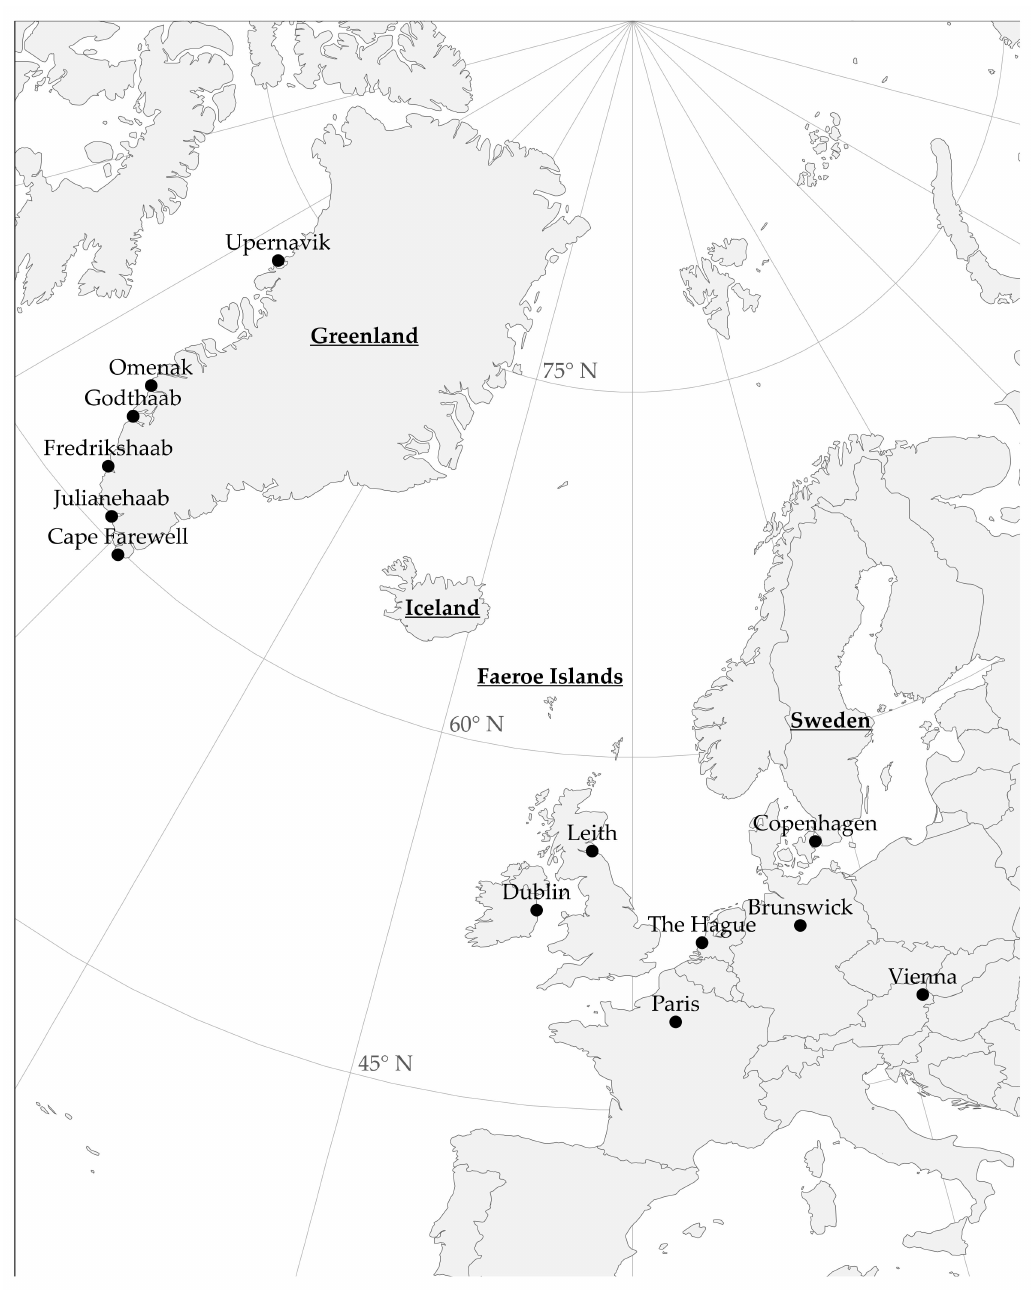
Figure 1. Map of Europe and Greenland with the names of important places pertaining to Prince Dimitri de Gallitzin and Karl Ludwig Giesecke. Original map credit: Chen-Pan Liao (CC BY-SA 4.0), the map has been